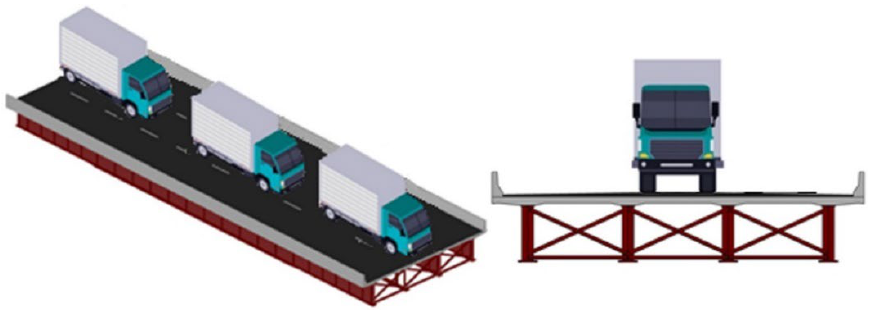
Figure 9. Vehicle convoys on the bridge deck: central traffic lane.